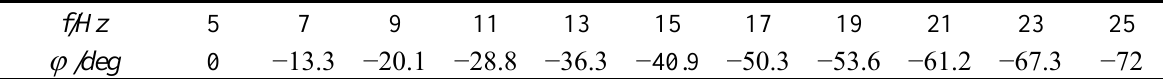
Table 1. Phase-frequency characteristic experimental